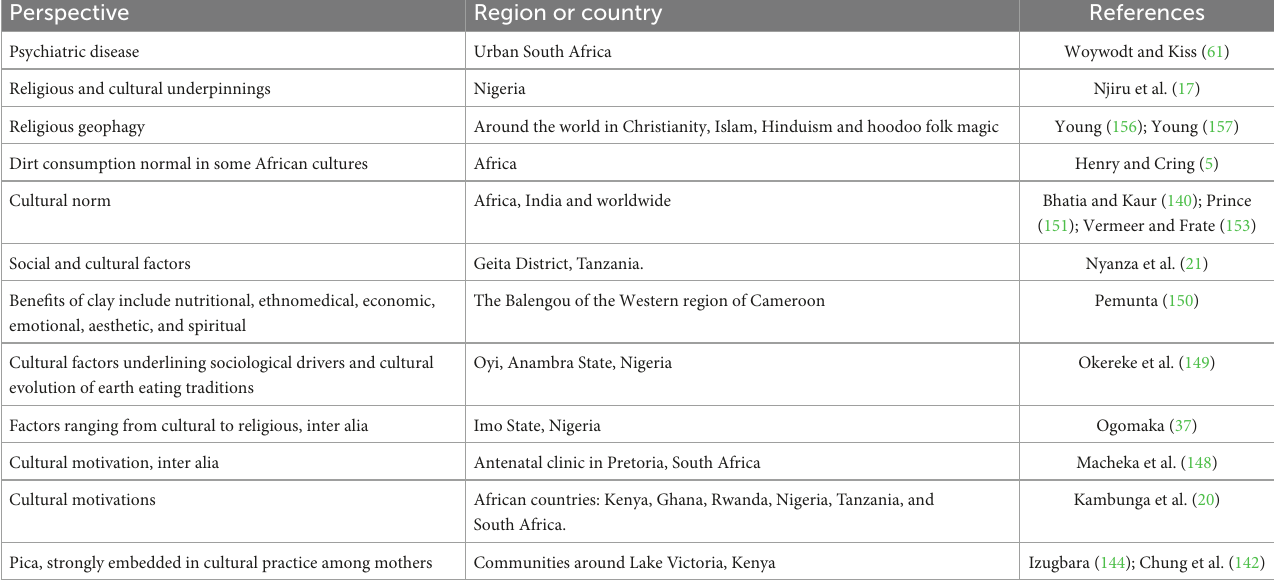
TABLE 2 Social, cultural, psychological and religious perspectives on geophagy in Africa.